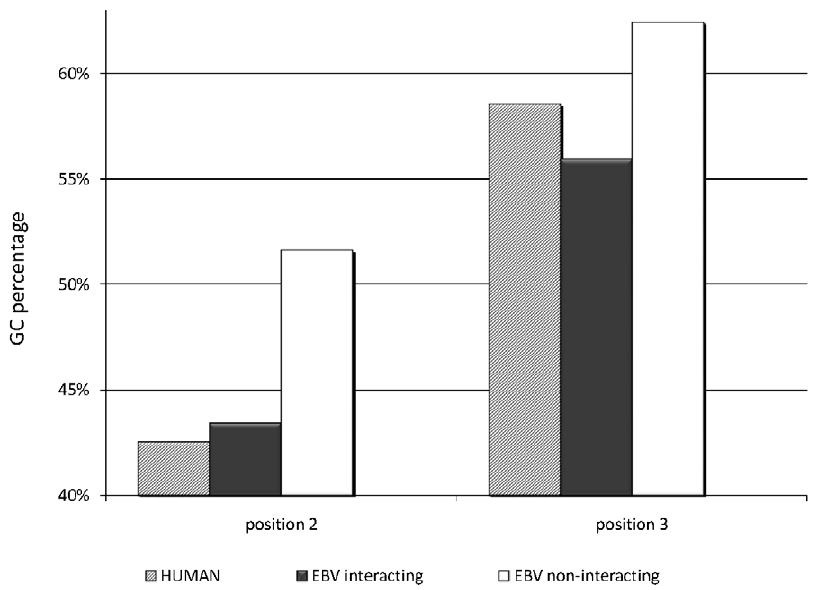
Figure 2. Comparison between interacting and non-interacting viral domains. Comparison of the average GC content in the 2nd and 3rd positions of the codon between (1) the human genome (gray bars), (2) viral domains that mediate host-virus protein interactions (black bars), and (3) viral domains were not found to mediate host-virus protein interactions (white bars). This comparison demonstrates the similarity in the GC content of the viral domains mediating the host-virus protein interactions and the human genome, as well as the differences in the GC content between the viral domains mediating the host-virus interactions and the viral domains not-mediating these interactions. A Pitman Permutation Test for the differences between the mediating and the non-mediating domains yielded statistically significant results (p-values: 2nd position: 2.3 6 10 2 3 ,3rd position: 0.01, calculated using StatXact version 9 software (Cytel Inc., Cambridge, MA)).